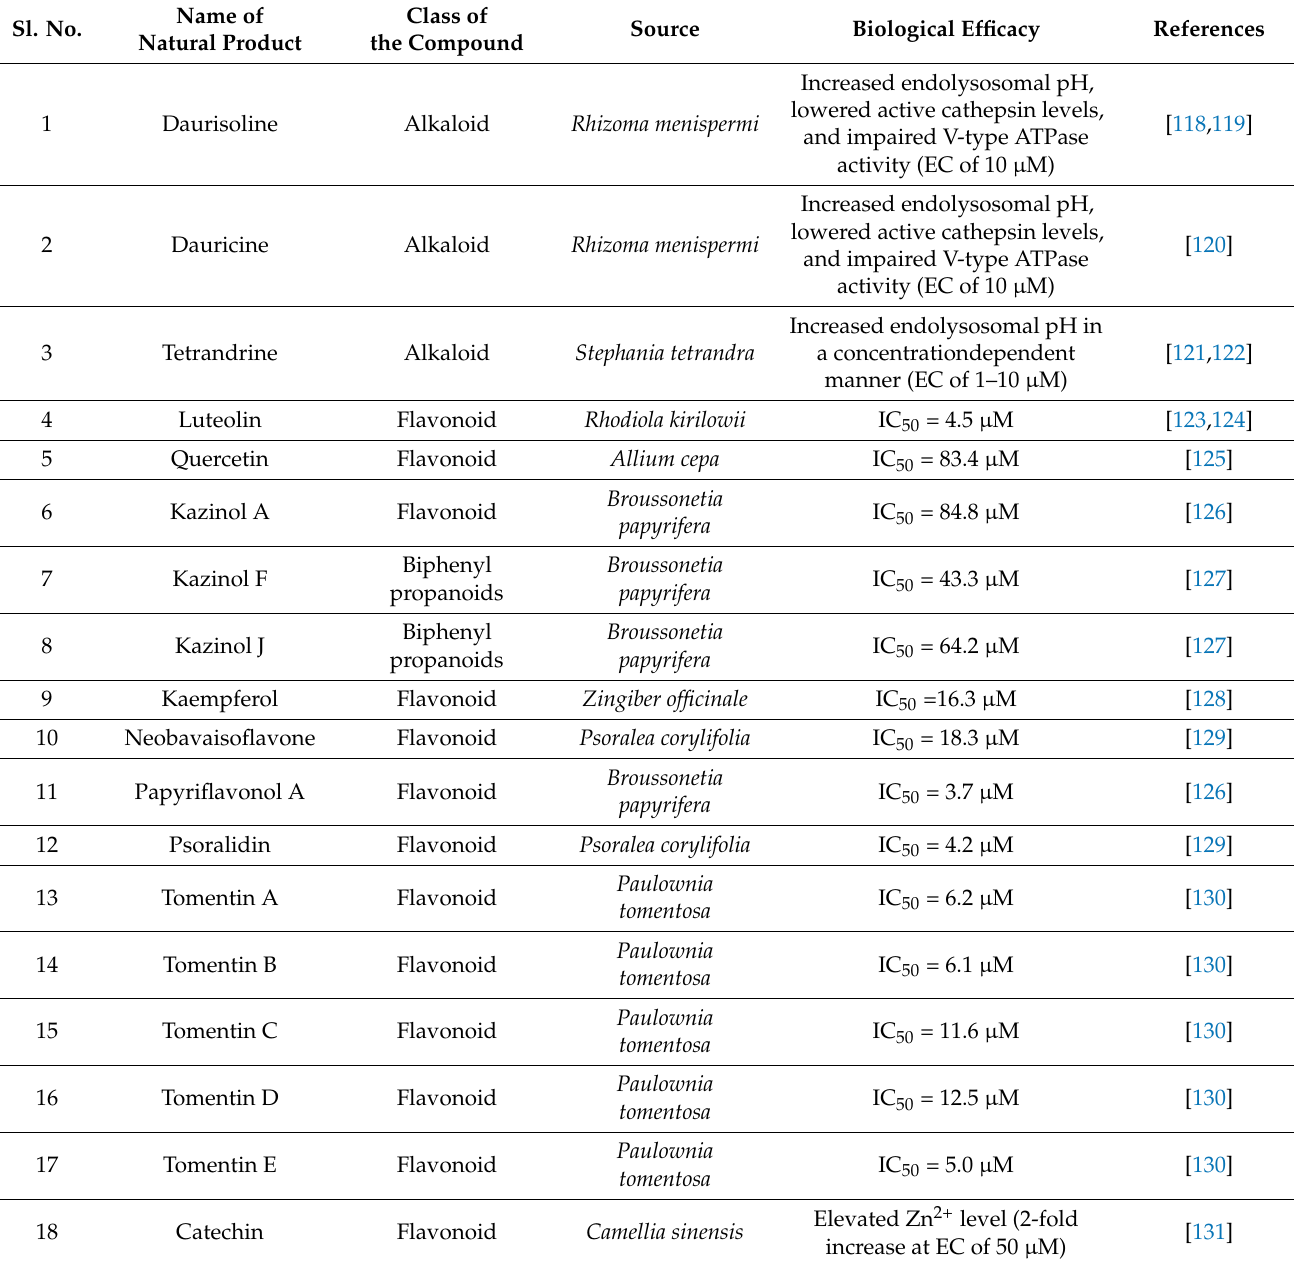
Table 2. List of some natural products, their classification, and possible mechanism of action. Sl.